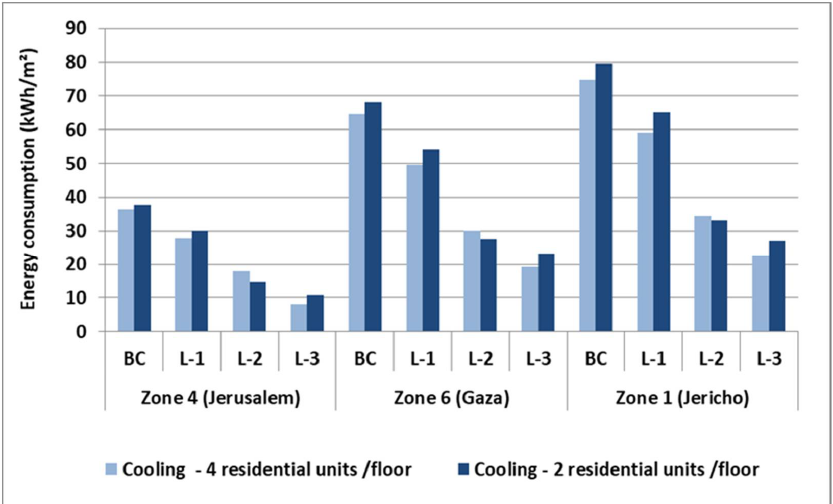
Figure 7. Comparing the saving in energy for cooling from applying the retrofit plans on buildings with two residential units per floor area versus four residential units per floor area in different climatic conditions in Palestine.